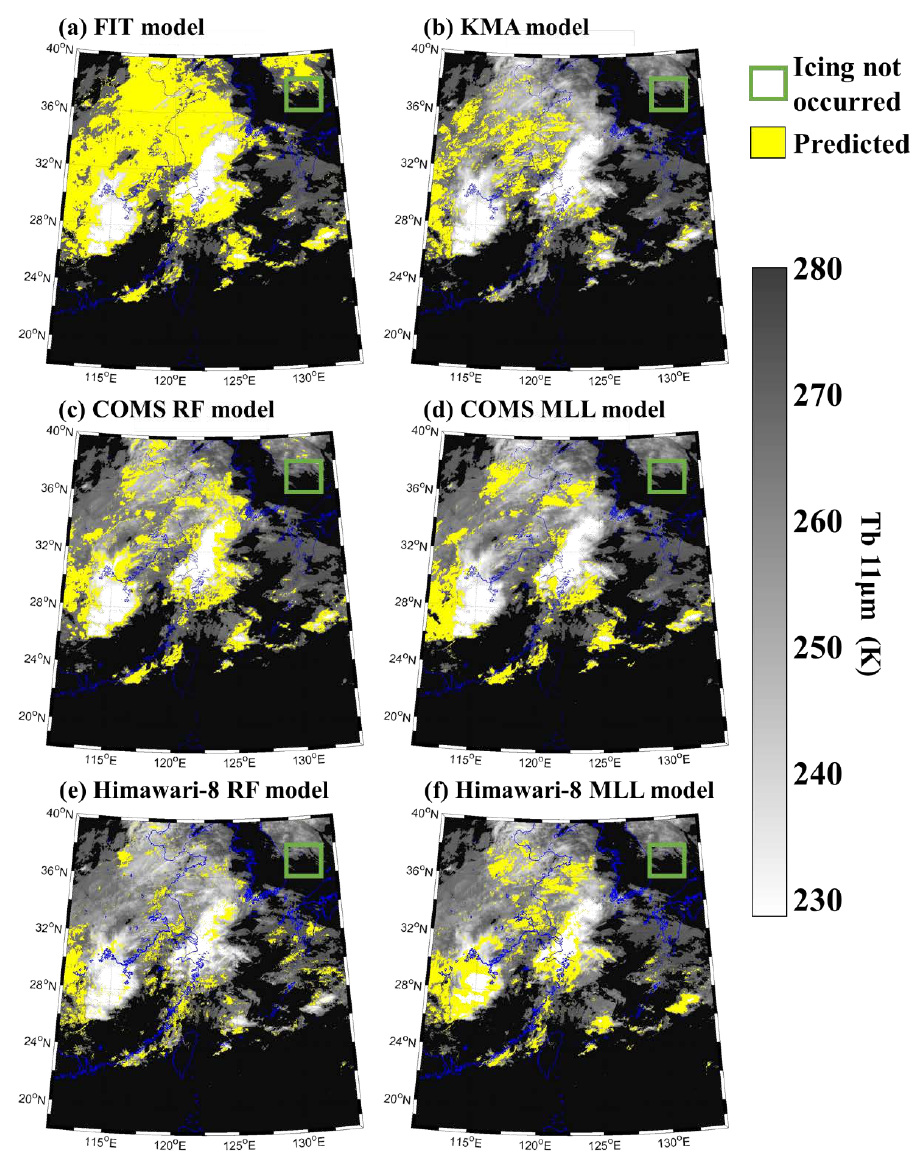
Figure 6. Maps of potential icing areas produced by the six algorithms for the COMS and Himawari- 8 images collected on 26 April 2016 01:00 UTC. The 11 µm channel Tb image ranging from 228 K